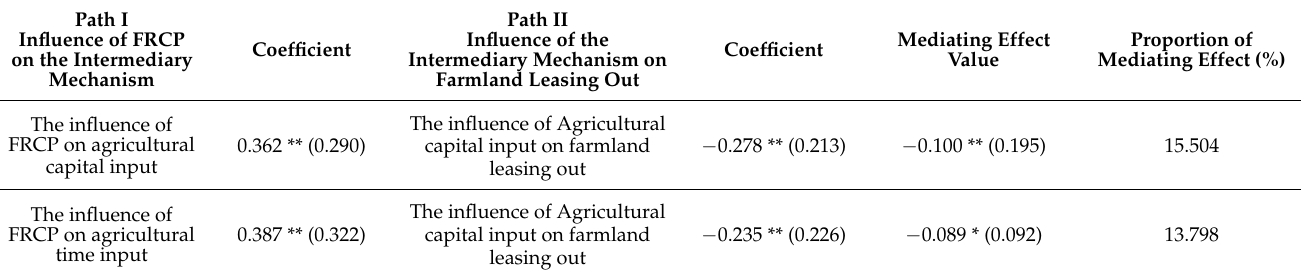
Table 5. The impact of FRCP on farmland leasing out: an analysis of the mediating